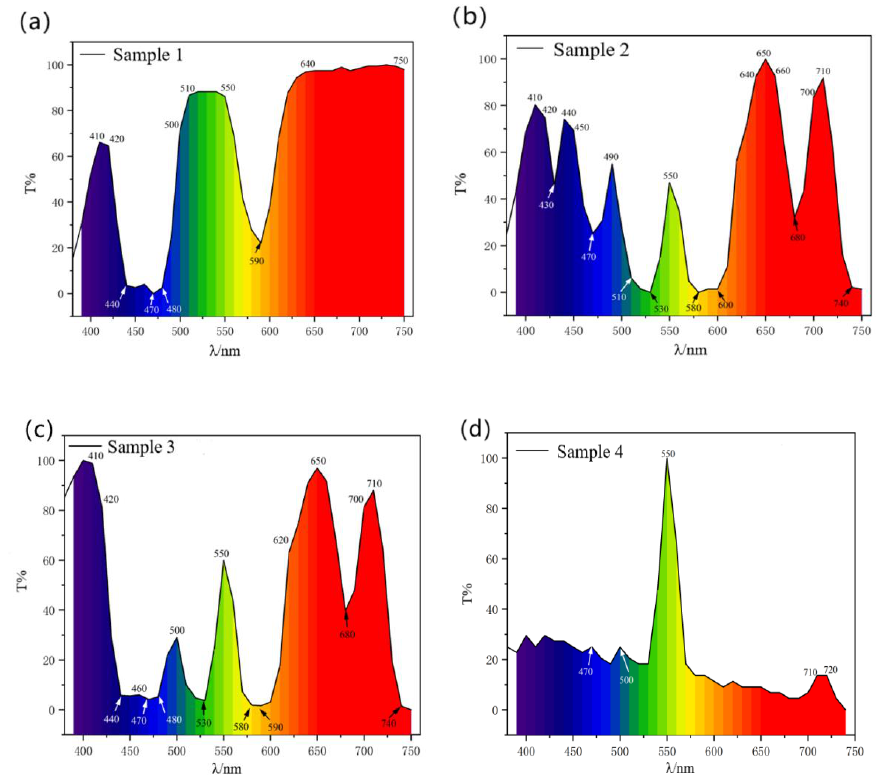
Figure 4. Transmission spectra of samples: ( a ) sample 1; ( b ) sample 2; ( c ) sample 3; and ( d ) sample 4.